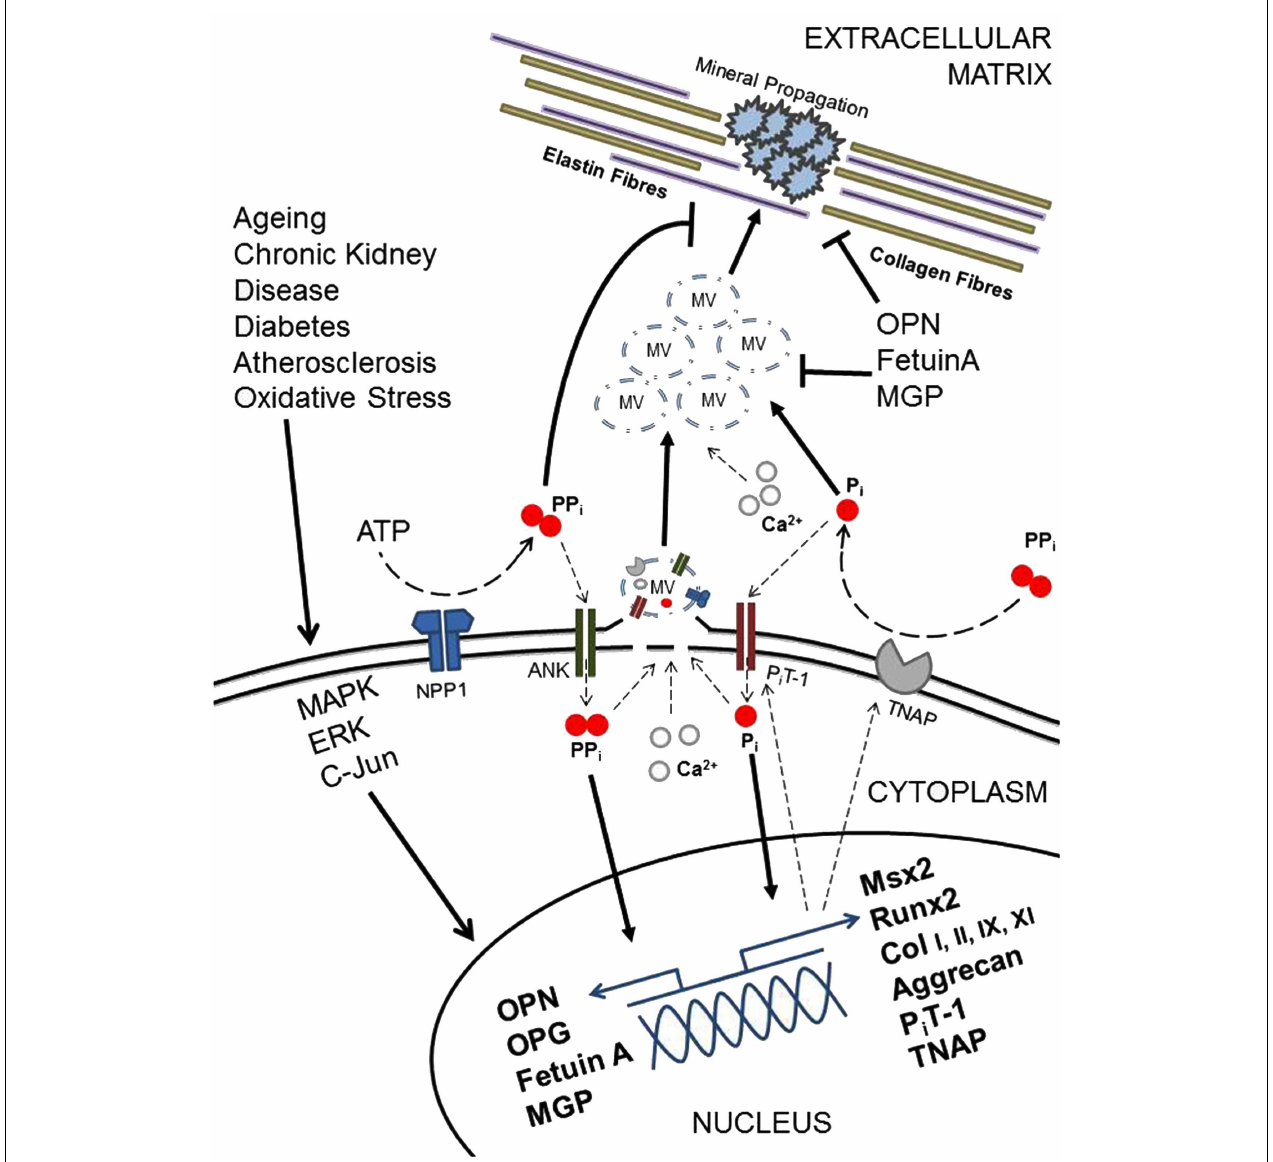
FIGURE 3 | Diagramatic representation of selected regulatory factors and their potential roles in vascular